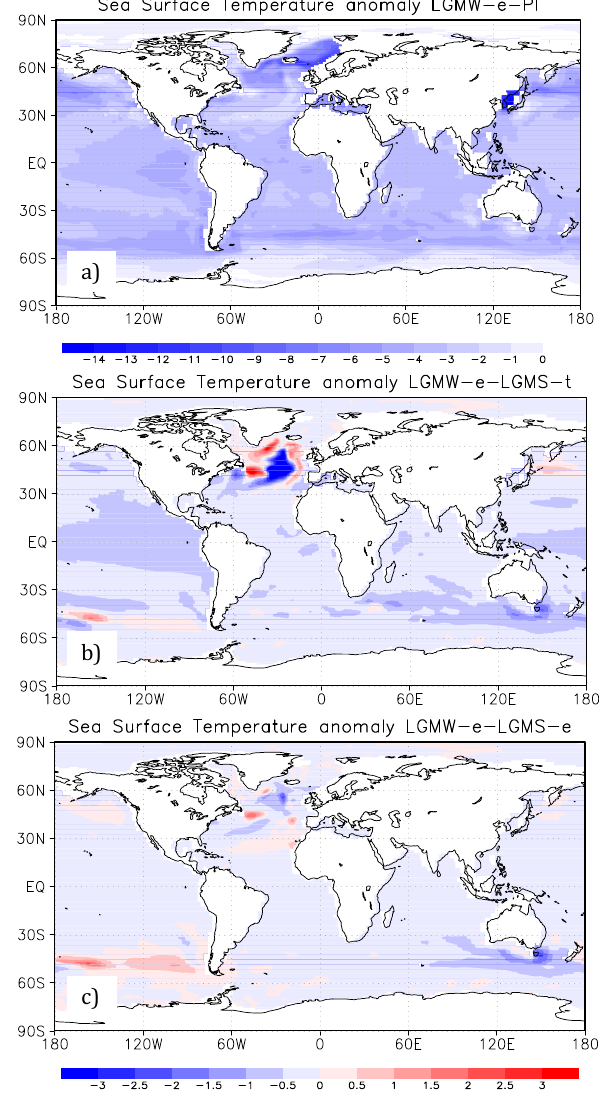
Figure 6 Anomaly of annual mean SST for a) LGMW-e minus PI, b) Fig. 6. Anomaly of annual mean SST for (a) LGMW-e minus PI, (b) LGMW-e minus LGMS-t deep and (c) LGMW-e minus LGMS- LGMW-e minus LGMS-t and c) LGMW-e minus LGMS-e. Units: C. deep e. Units: ◦